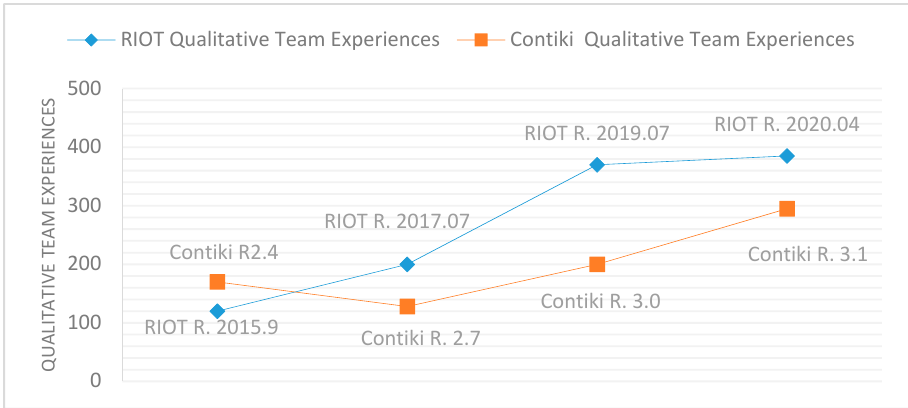
Figure 10. Qualitative Team Experiences evolution of RIOT and Contiki releases. For more clarifications, we expressed the relationship between the evolutionary prop- erties and the presence of IoT OS vulnerabilities by calculating the linear correlation coefficient between security errors and code evolutionary properties, as shown in Table